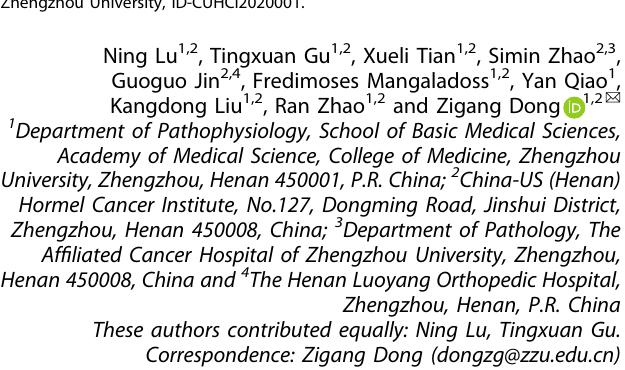
Fig. 1 Anti-viral and anti-in fl ammatory effects of acetylshikonin in vivo and in vitro. a The binding mode of acetylshikonin with PL pro (PDBID: 7LBR) predicted by the Autodock VINA program. Acetylshikonin is represented as a purple stick, while PL pro is represented as a ribbon diagram. The key residues interacting with the acetylshikonin are shown in line. b The af fi nity between acetylshikonin and PL pro. c Inhibitory rate of different concentrations of acetylshikonin on PL pro. d RAW264.7, BMDM and lung single cells were induced with poly (I:C) (16 µg/mL) and treated with different concentrations of acetylshikonin (0, 0.6, 1.25, 2.5 μ M) for 12 h. The concentration of IL-6 in the cell supernatant was then quanti fi ed by ELISA assay. Data represented the concentration of IL-6. e The effect of acetylshikonin on NF- κ B signaling in RAW264.7 cells was assessed by Western blot analysis followed by densitometric quanti fi cation. The cells were treated with poly (I:C) (16 µg/ml) and 0, 0.6, 1.25 or 5 μ M acetylshikonin and harvested at 24 h and 48 h. Cell lysates were then subjected to Western blotting. The results showed the expression of phosphorylated P38 and phosphorylated NF- κ B upon treatment with acetylshikonin. f Effect on the nuclear translocation of p- NF- κ B and p-P38. Cells were treated with poly (I:C) (16 µg/ml) and different concentrations of acetylshikonin. g The concentrations of IL-6, TNF- α and IL-1 α with 300 mg/kg acetylshikonin and 15 mg/kg anti-IL-6 mAb in an acute lung injury mouse model. h H&E staining of lung tissues. (magni fi cation: ×40 m, ×100 m). i The binding of acetylshikonin with endogenous PRDX1 present in RAW264.7 cell lysate was determined